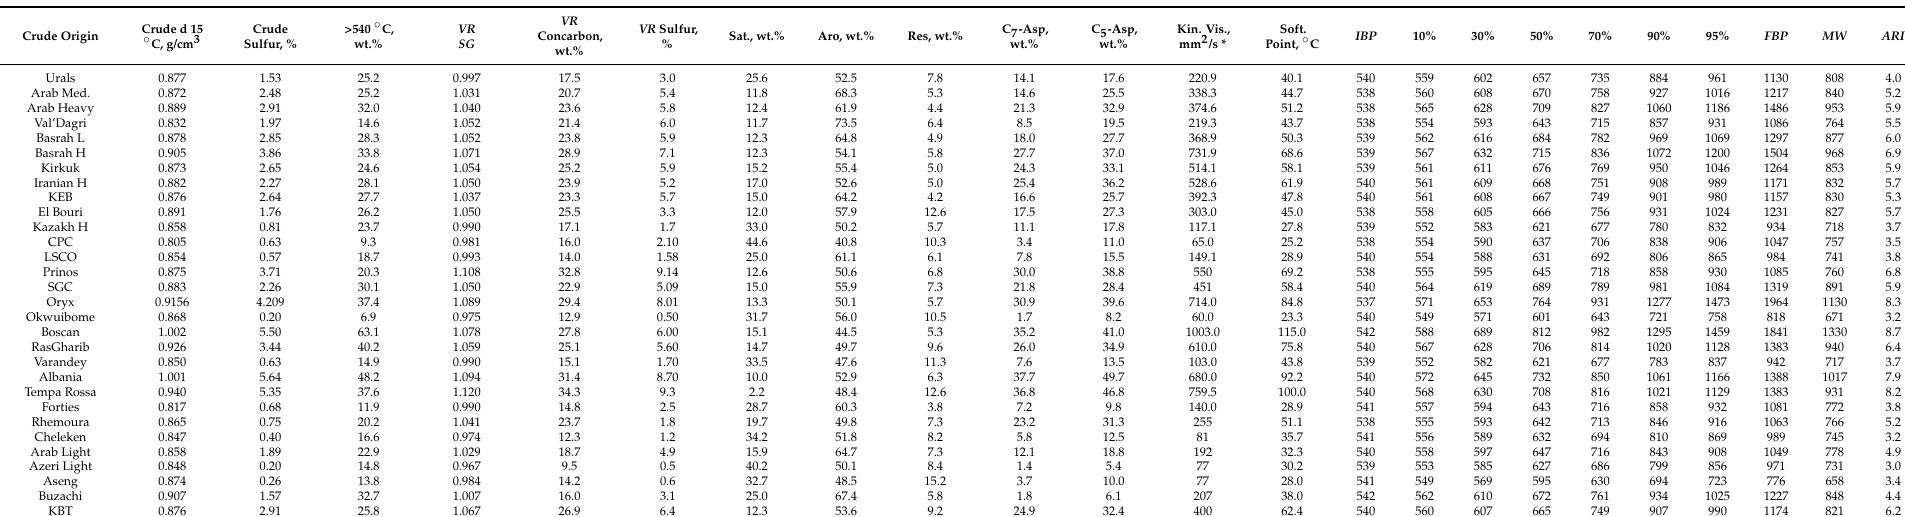
Table 2. Physicochemical properties of SRVR s and of the crude oils from which they originated.